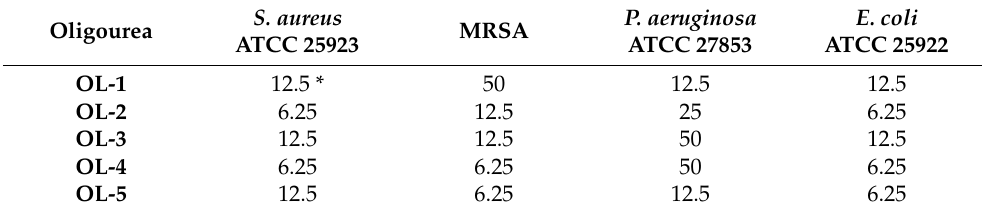
Table 1. Antibacterial activity of the urea-based foldamers (MIC in µ g/mL). Each foldamer was incubated for 24 h at 37 ◦ C in 100 µ L of Mueller–Hinton broth (MHB) medium with the bacterial strain. The control is composed of the bacterial suspension mixed with PBS (=corresponds to 100% growth). The lowest concentration for which bacterial growth is 0% corresponds to the MIC of the tested compound. Each value corresponds to the mean value of 3 samples. * See Table S2 for MIC in µ M. S. aureus Oligourea ATCC 25923